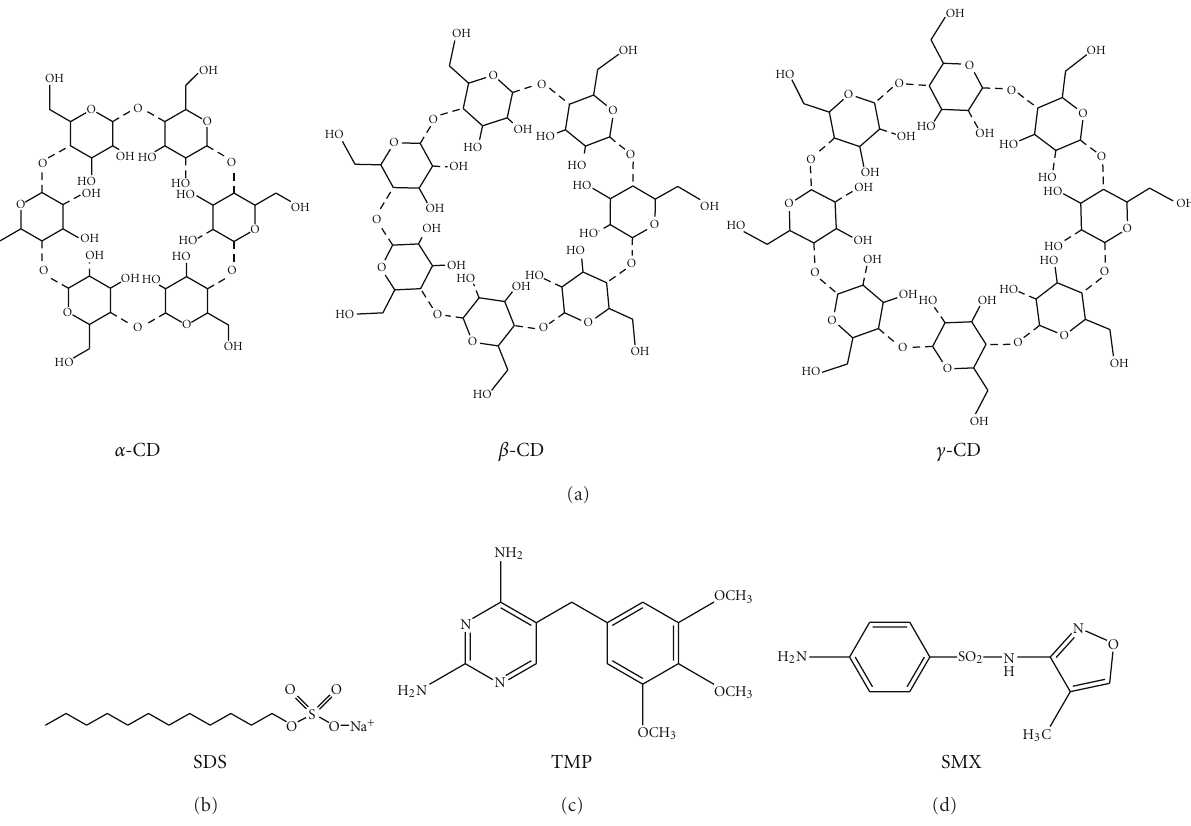
Figure 1: Chemical structures of α -CD, β -CD, γ - CD, SDS, TMP, and